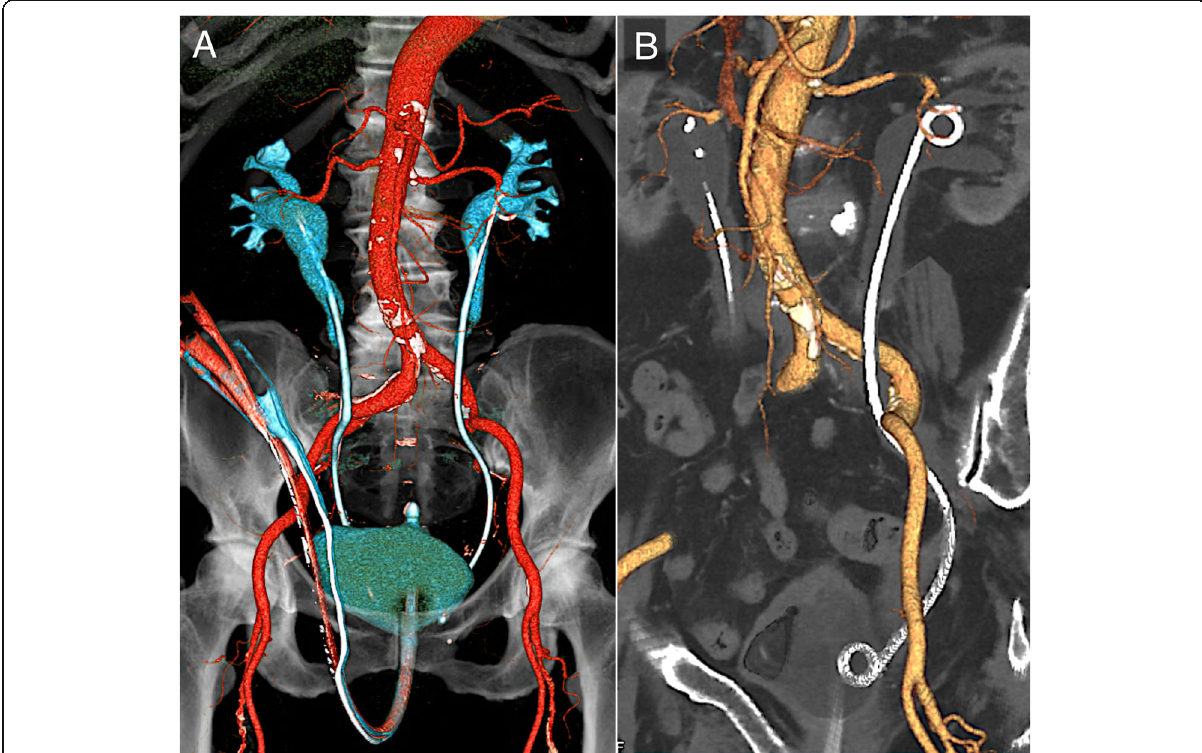
Fig. 1 Computed tomography after the hemostasis of hematuria. a Computed tomography (CT) showed the crossing of the left ureter with a stent over the distal common iliac and internal iliac arteries. b CT imaging in the angulated 30-degree left anterior oblique